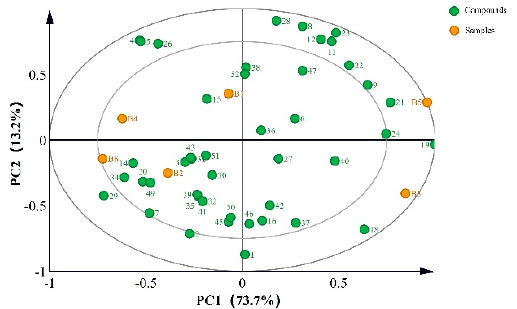
Figure 1. Principal component analysis model of the key aroma compounds in different vinegar samples. The sample codes correspond with Table 1. The number of compounds corresponds with Table